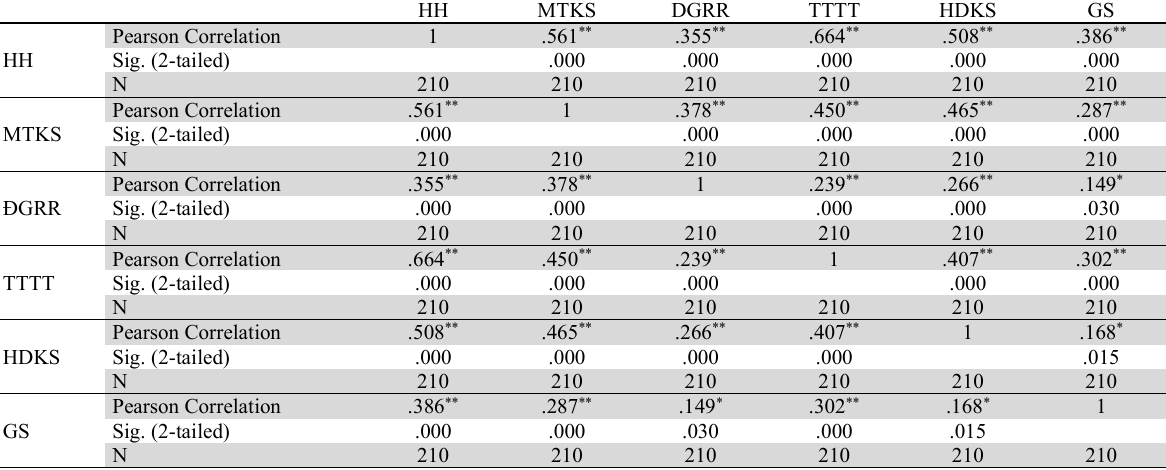
The results of Pearson correlation test